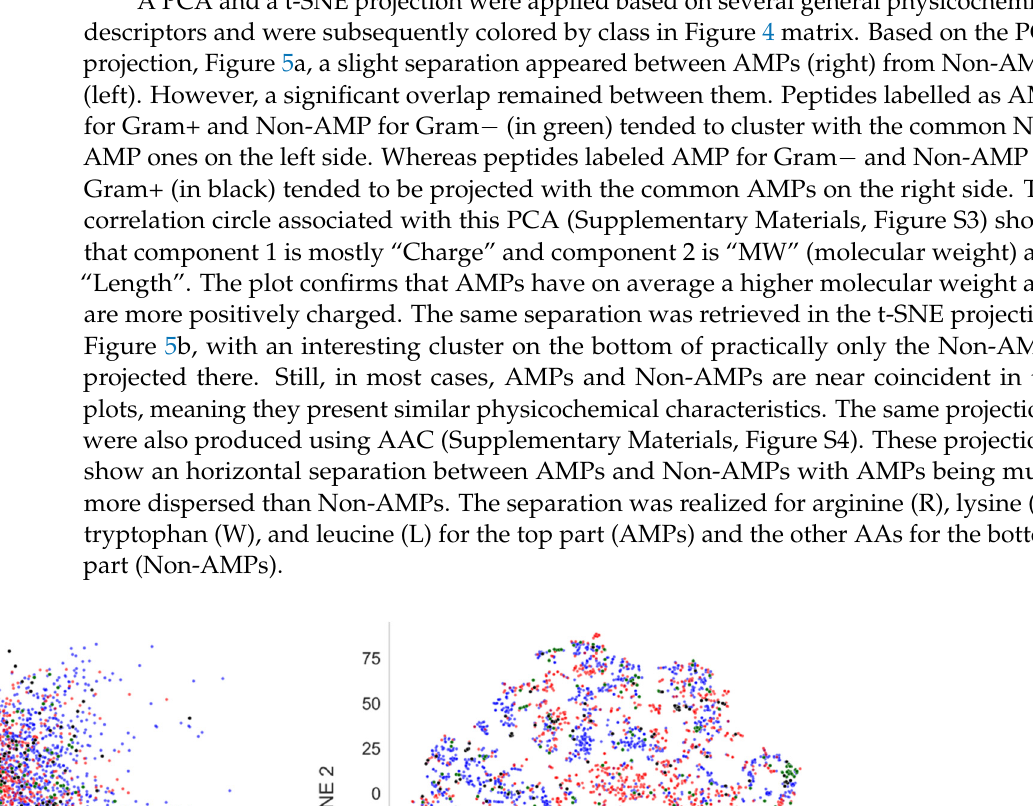
Figure 4. Matrix of labels for the common peptides between Gram − and Gram+ categories.